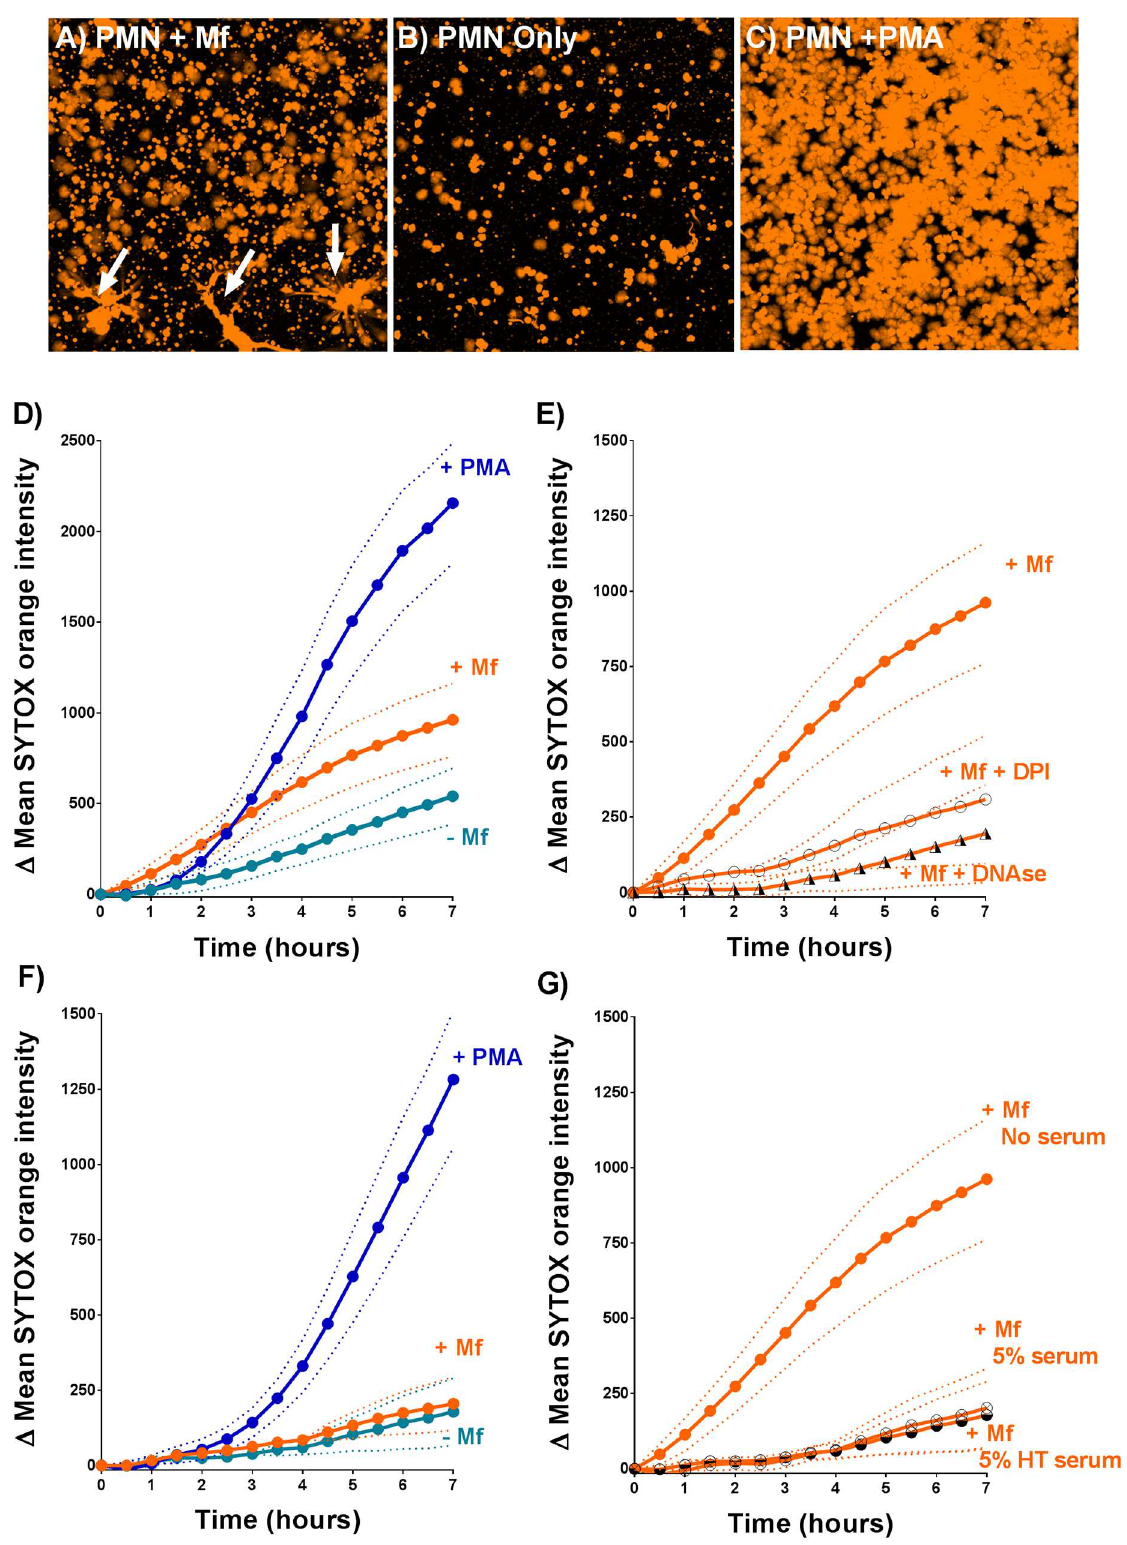
Fig 2. Extracellular DNA releasefrom human PMNs. A-C: Images of SYTOX Orange-labelled extracellular DNA present within Mf-treated (A), zero Mf (negativecontrol) (B) and PMA-treated (positivecontrol) (C) wells. The images were taken 7 hours post-